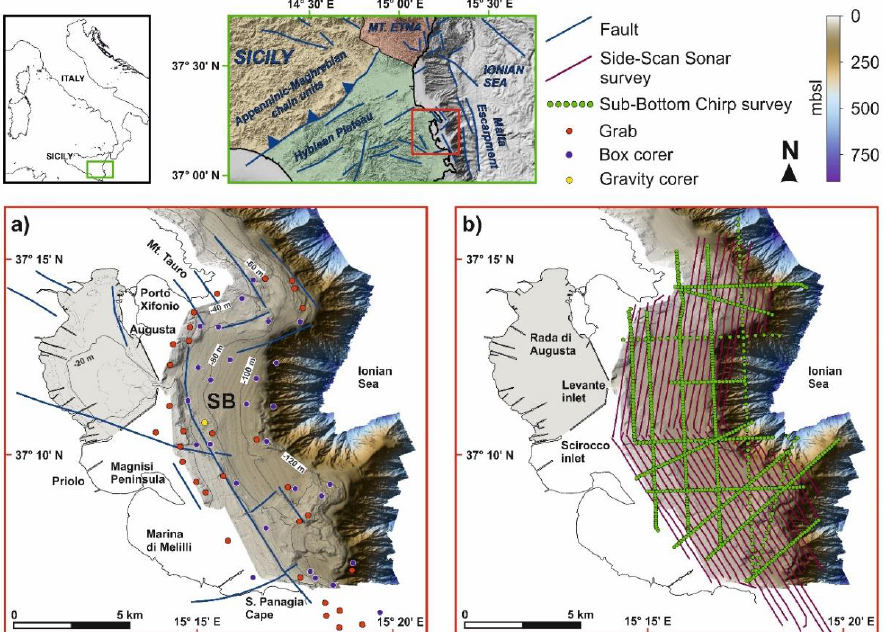
Figure 1. ( a ) Morpho-bathymetry of Augusta Bay [22,24]; blue lines mark the main faults bounding a depocentral area (Shelf-Basin, SB) of the continental shelf; coloured dots indicate the sampling sites. Depth contours are every 5 m. Bathymetry inside Rada di Augusta harbor is from ICRAM [6]. ( b ) Track lines of Side-Scan Sonar and sub-bottom Chirp Sonar surveys. The insets above are modified from [23] .